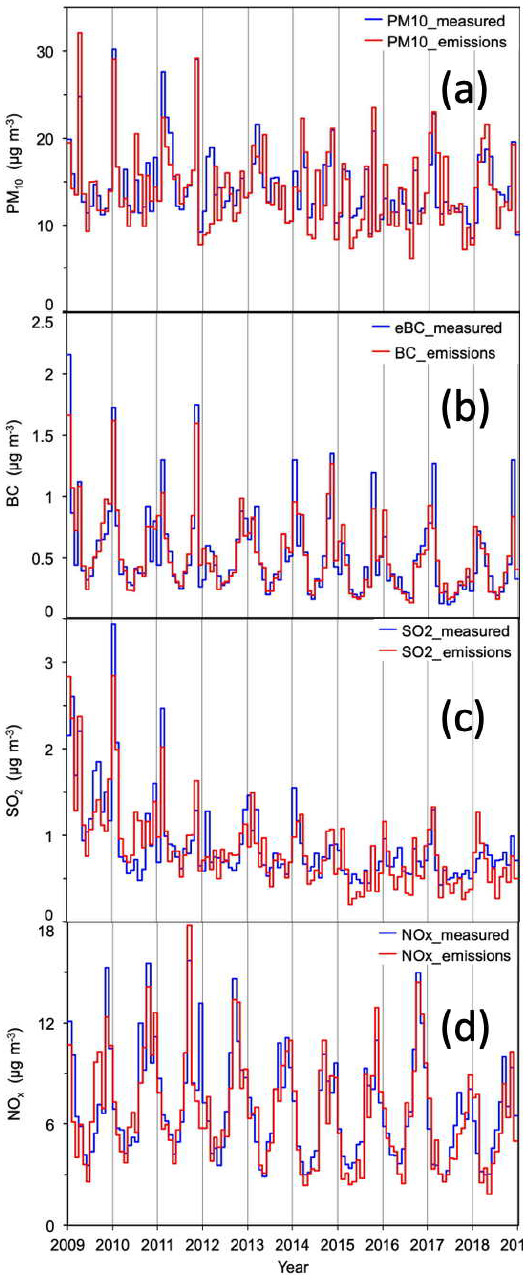
Figure 5. (a) Monthly medians of PM 10 concentrations at the four stations in the present study (blue) and monthly medians of opti- mized sums of PM 10 emissions along back trajectories leading to the stations (red). Panel (b) is as (a) but for measured eBC concen- trations and BC emissions along back trajectories. Panel (c) is as (a) but for measured SO 2 concentrations and SO 2 emissions along back trajectories. Panel (d) is as (a) but for measured NO x concentrations and NO x emissions along back trajectories.